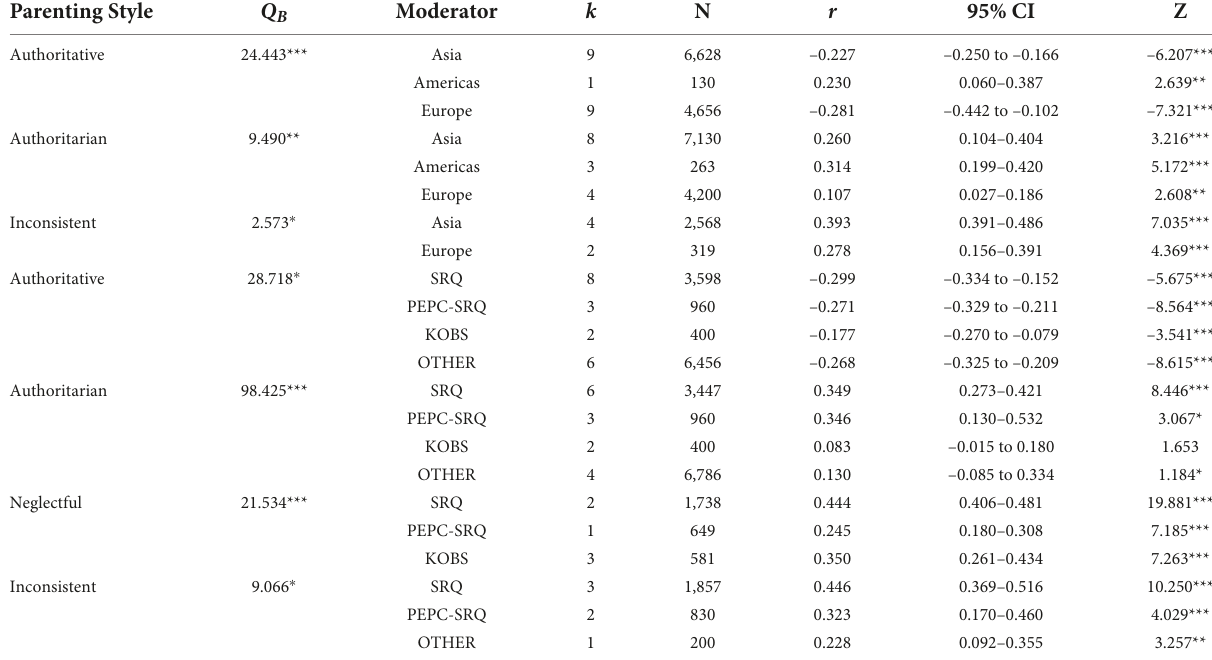
TABLE 4 Moderating effect of categorical variables.